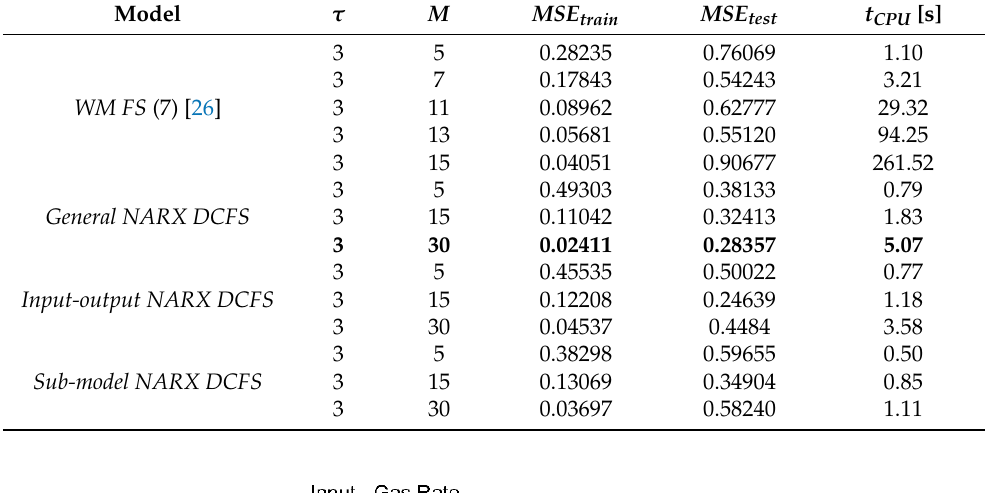
Table 2. Comparison of the performance of the proposed methods in Box–Jenkins system identifica- tion problem.